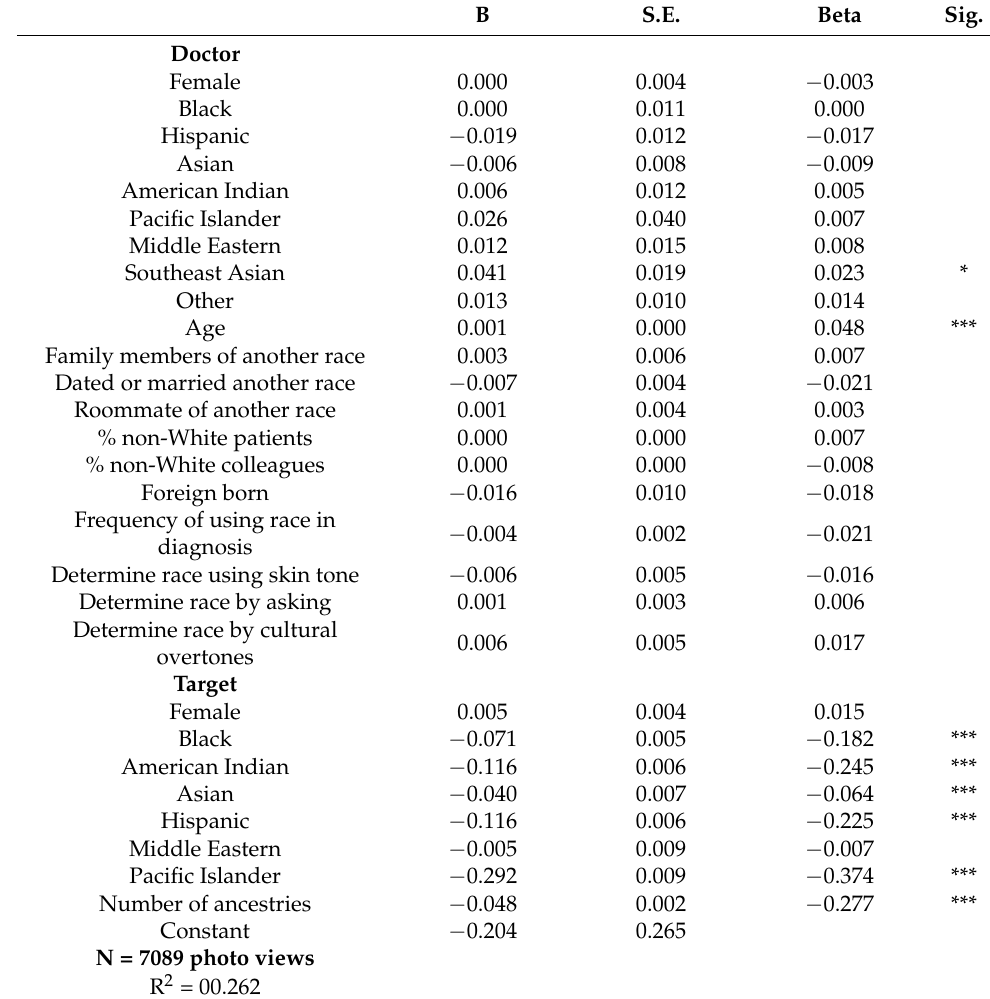
Table 6. Multiple regression of Type 3 congruence on doctor and target characteristics. B S.E.